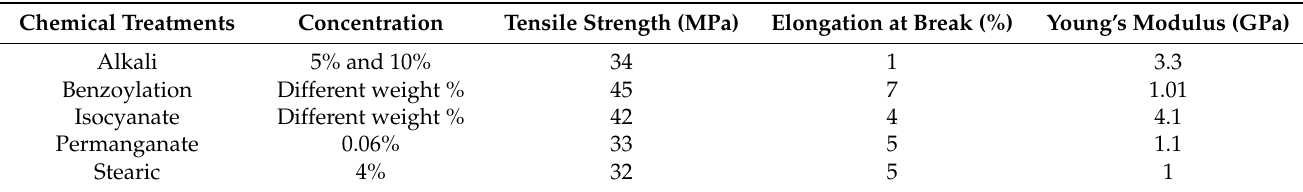
Table 4. Effect of different chemical treatments on sisal-fiber-reinforced composites [100,124,125]. Chemical Treatments Concentration Tensile Strength (MPa) Elongation at Break (%) Young’s Modulus (GPa) Alkali 5% and 10% 34 Benzoylation Different weight % 45 Isocyanate Different weight % 42 Permanganate 0.06% Stearic